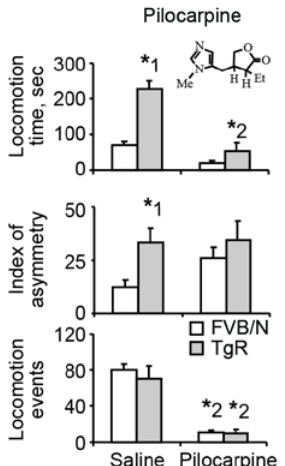
Figure 2. Pilocarpine suppresses the motor hyperactivity but not the locomotor asymmetry component of SB. Shown are the effects on motor activity in the open field. Pilocarpine, a muscarinic agonist, at a dose of 25 mg/kg, suppressed motor activity without affecting motor asymmetry. * 1 marks a significant transgene effect. * 2 marks a significant drug effect.